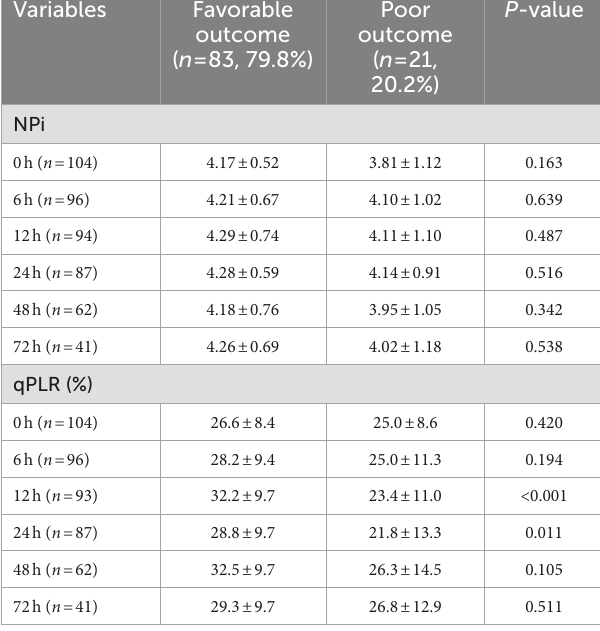
TABLE 3 Pupillometer data recorded at each point in time after carbon monoxide poisoning categorized according to outcome groups.